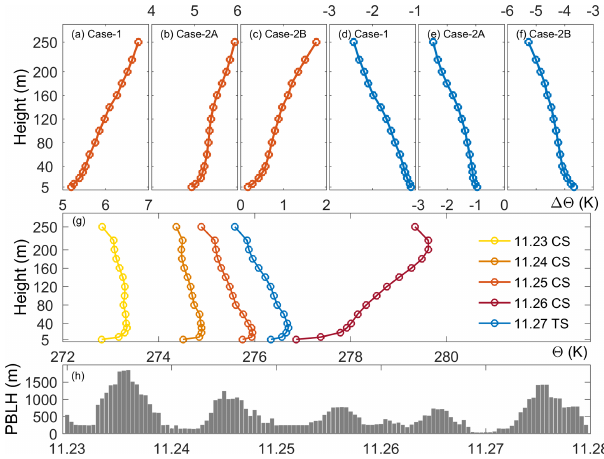
Figure 3. Vertical distribution of daily mean potential temperature. The change of daily mean potential temperature of CSs is shown in (a) – (c) , and this is shown for TSs in (d) – (f) . Panel (g) illustrates the evolution of inversion layer of Case-1. Panel (h) is the PBLH simulated with the WRF